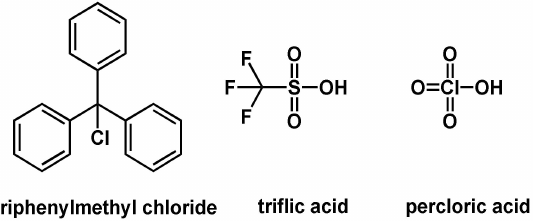
Figure 9. Chemical structures of common types of cationic